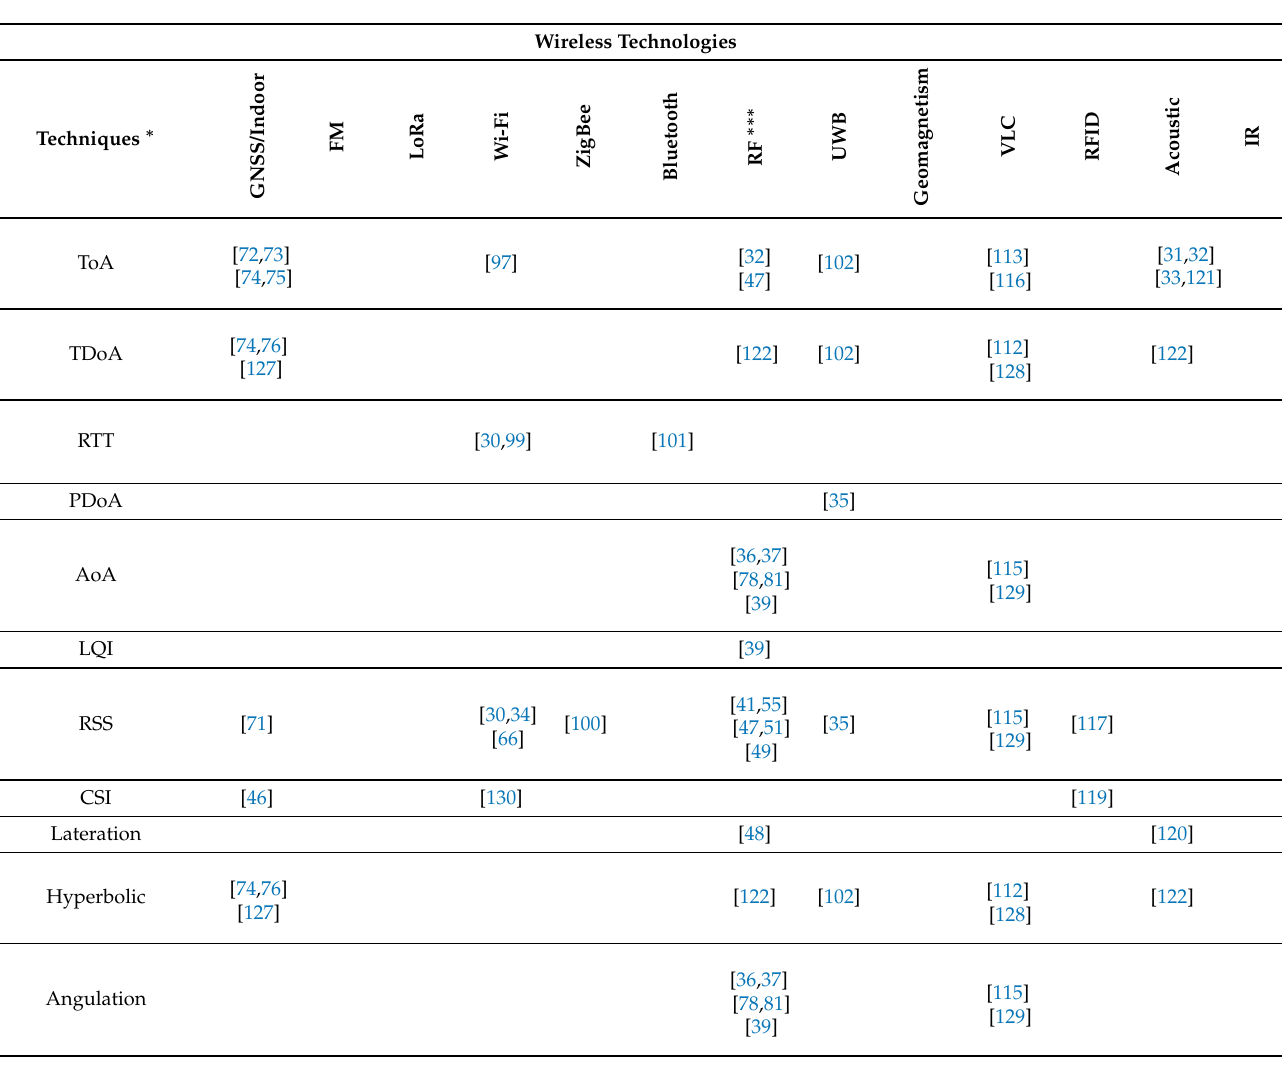
Table 3. Matching between the different localization techniques and wireless technologies in the related